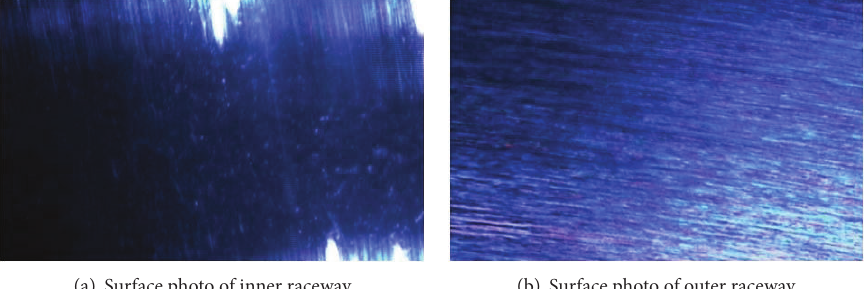
Figure 10: Surface photo of raceways under VMS-1510G.